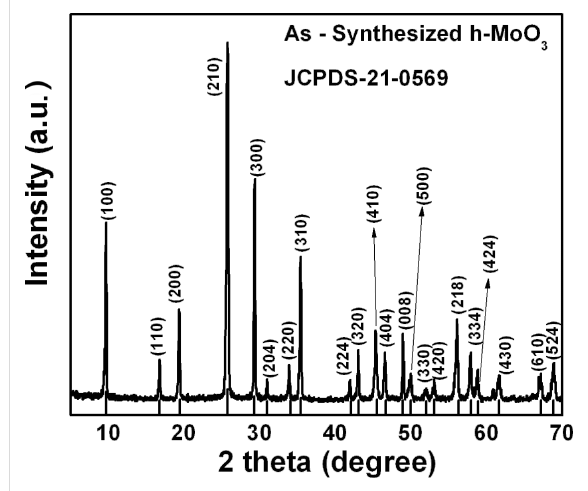
Figure 1: XRD pattern of as-synthesized h-MoO 3